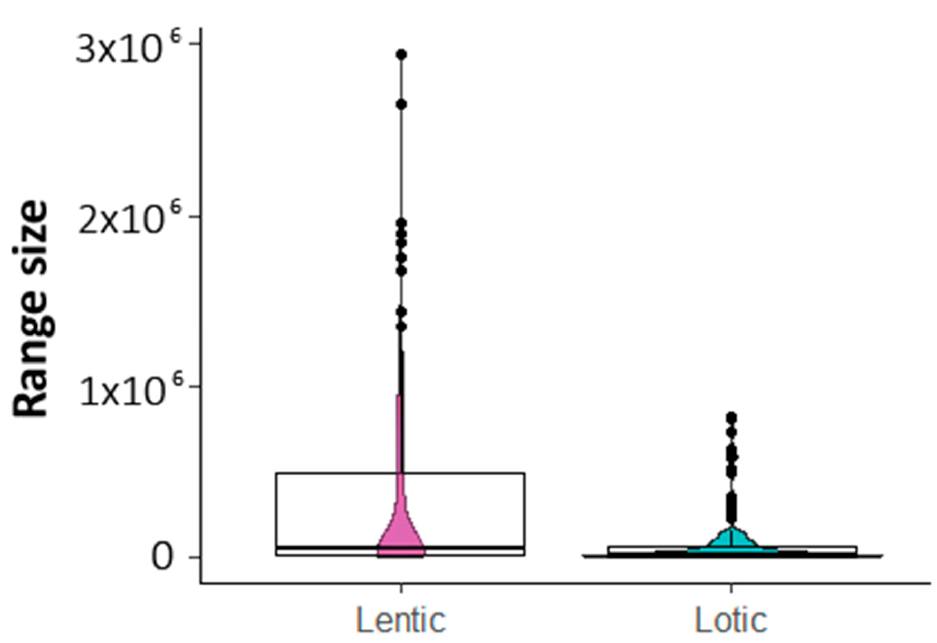
Figure 3. Range size (defined by the number of cells with predicted presence) for lentic- and lotic- dependent Odonata species.